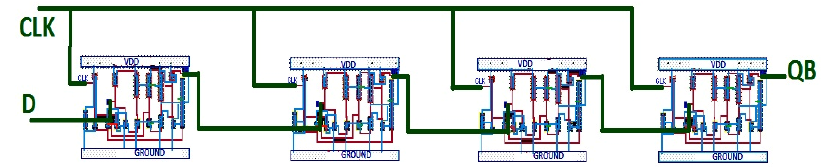
Figure 16. Layout of the SISO shift register.